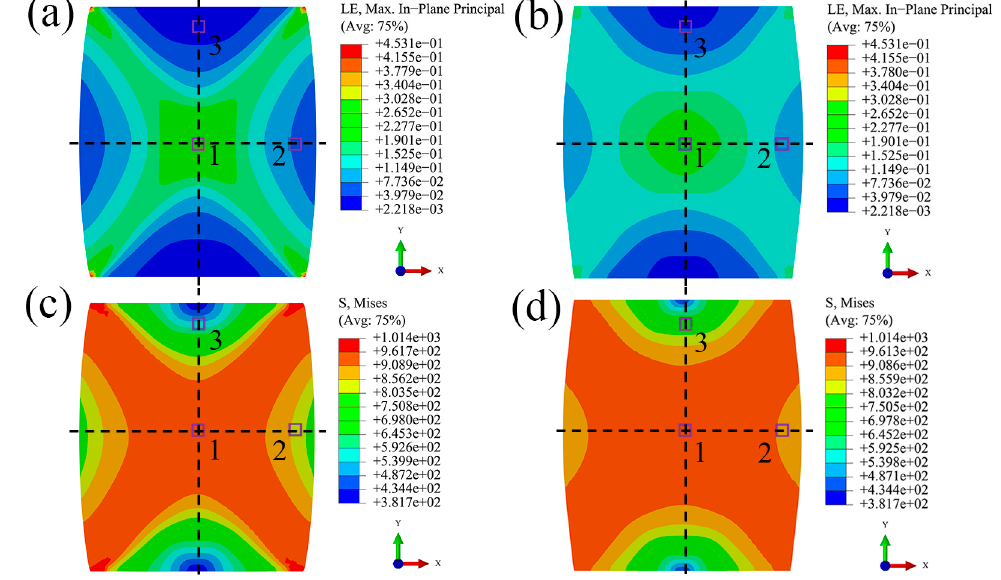
Figure 4. Macroscale strain and stress distribution of NiTi SMA at the deformation degree of 12%: ( a , c ) under uniaxial compression process; ( b , d ) under canning compression process. (Regions 1, 2, and 3 of interest correspond to three characteristic deformation zones during plastic deformation.)